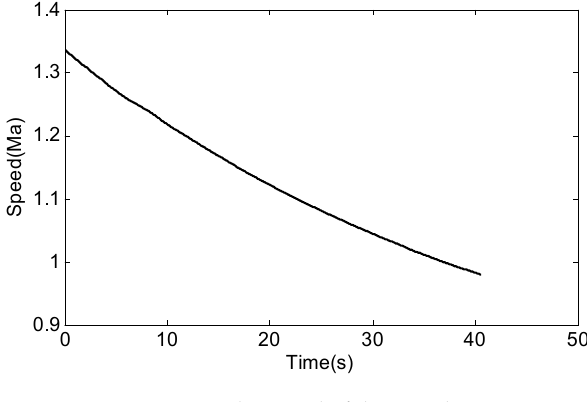
Figure 7. The speed of the missile.